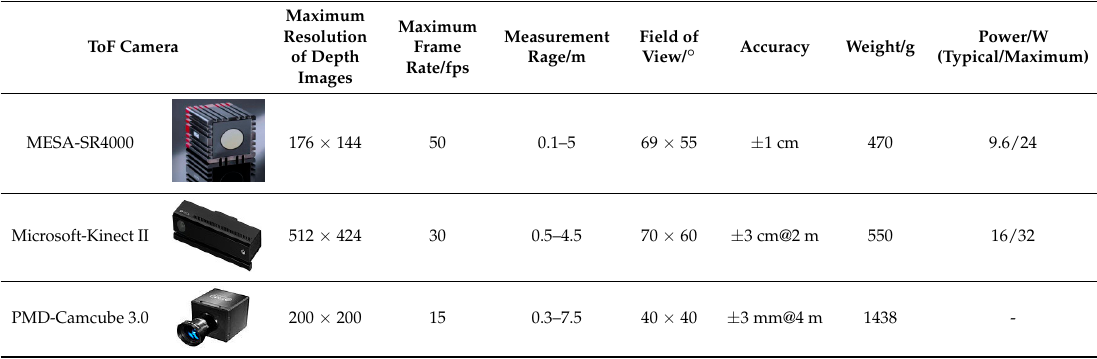
Table 1. Parameters of typical commercial ToF cameras.